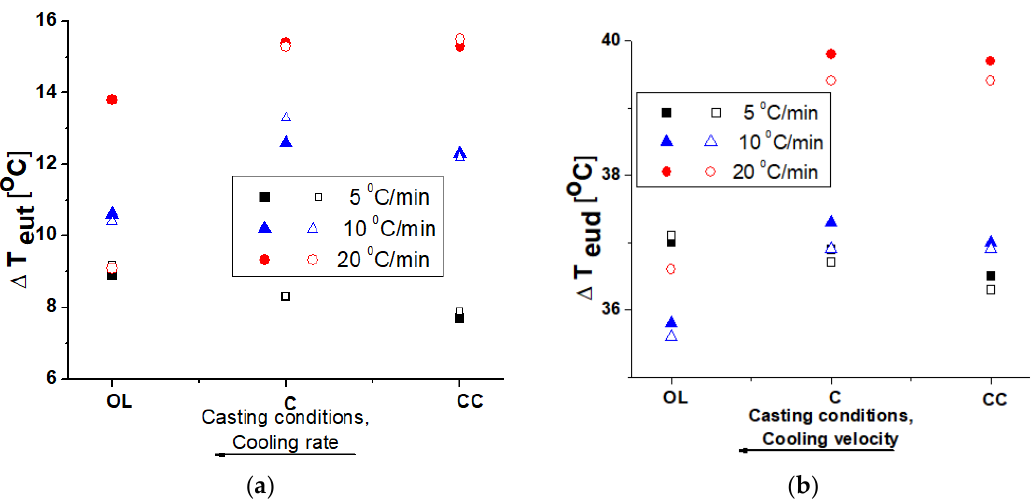
Figure 8. Variation of the degree of overcooling as a function of the casting conditions. ( a ) at the eutectic transformation; ( b ) at the eutectoid transformation.